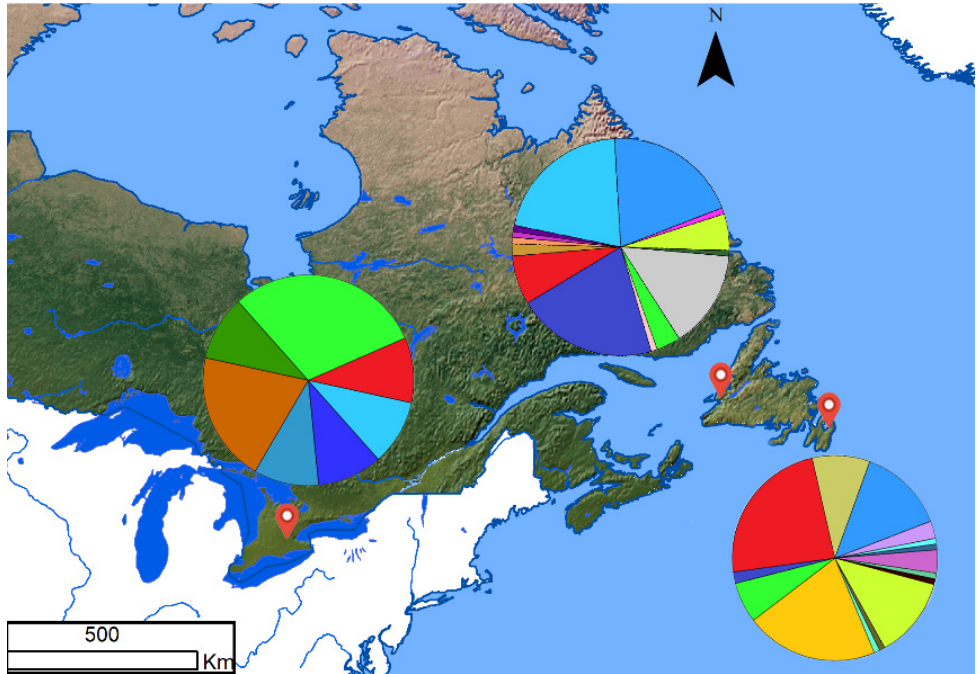
Figure 1. Geographical distribution of 28 MLGs of C. enelensis . The frequencies of the MLGs in each site are indicated by the pie diagrams.